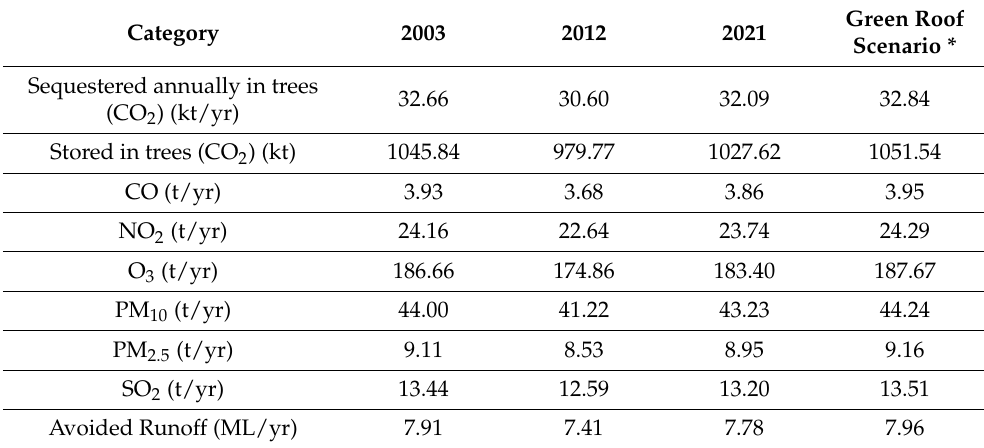
Table 3. Evaluation of urban tree services by year and green roof